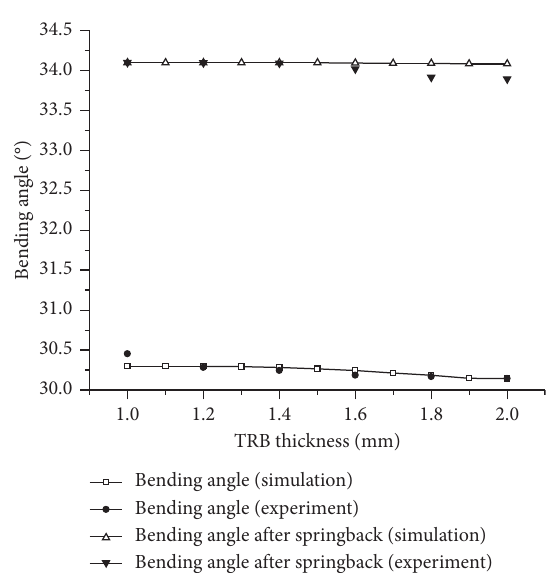
Figure 10: Comparison between the measured and simulated bending